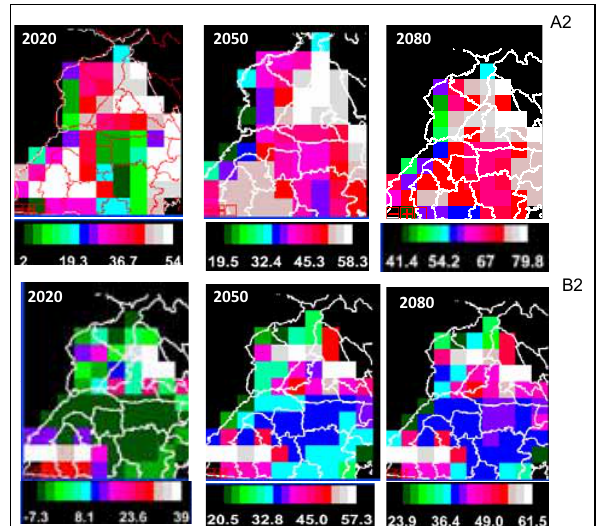
Figure 4: Reduction in cropping system yield in Punjab under A2 and B2 scenarios